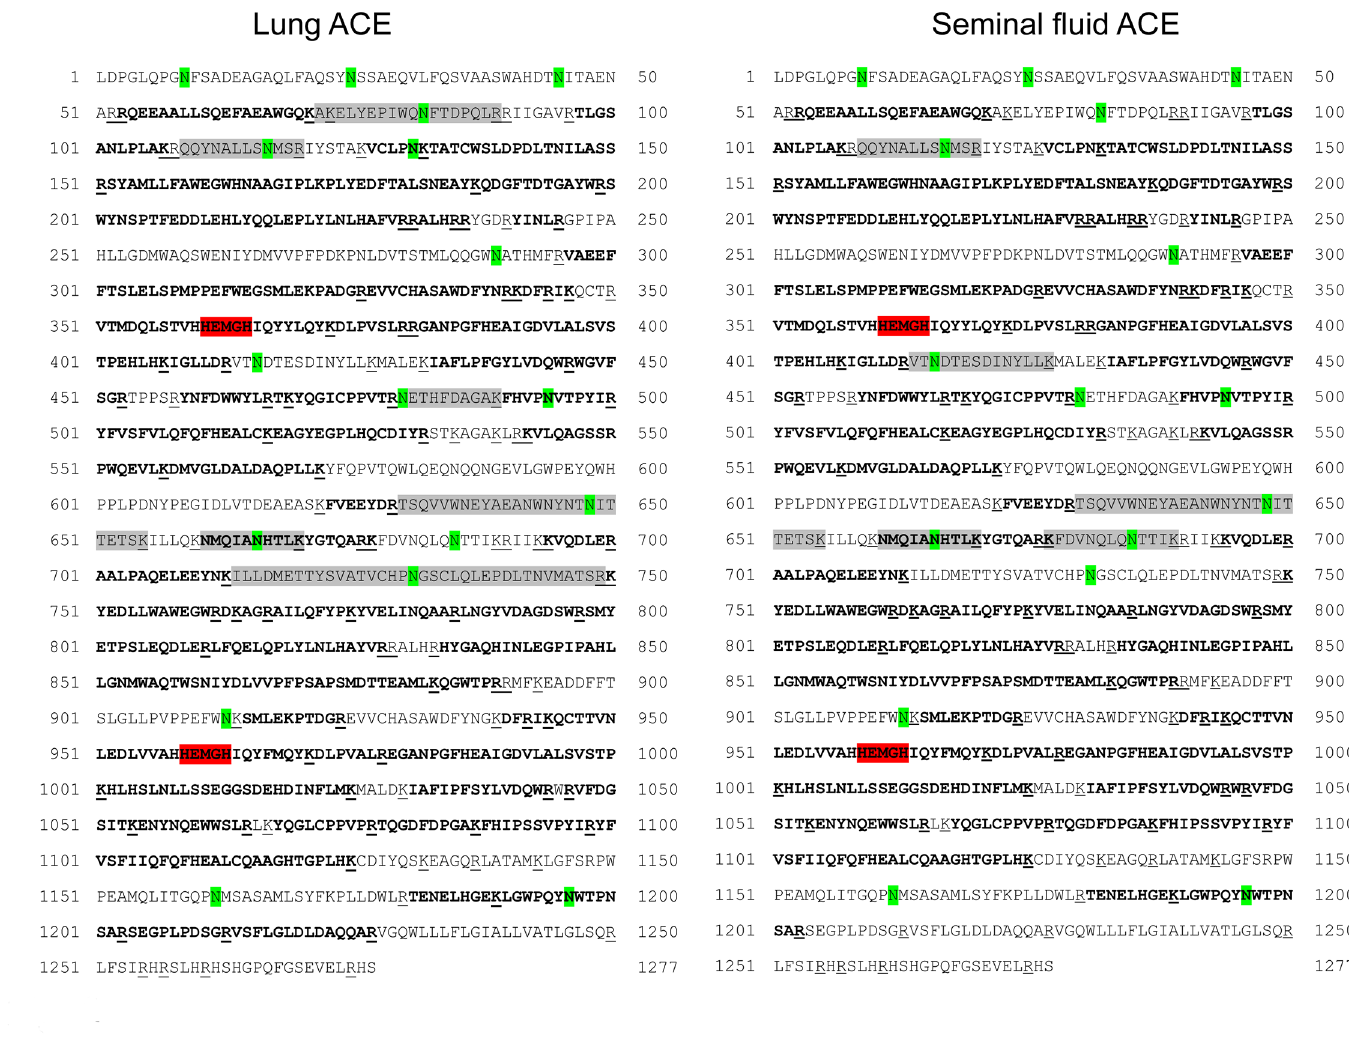
Fig 2. Amino acid sequences of the lung and seminal fluid ACEs. Peptides identified by MALDI TOF MS are shown in bold; potential sites of trypsin cleavage are underlined; potential glycosylation sites are marked by green; zinc-recognizing motives are marked by red; putative glycopeptides are